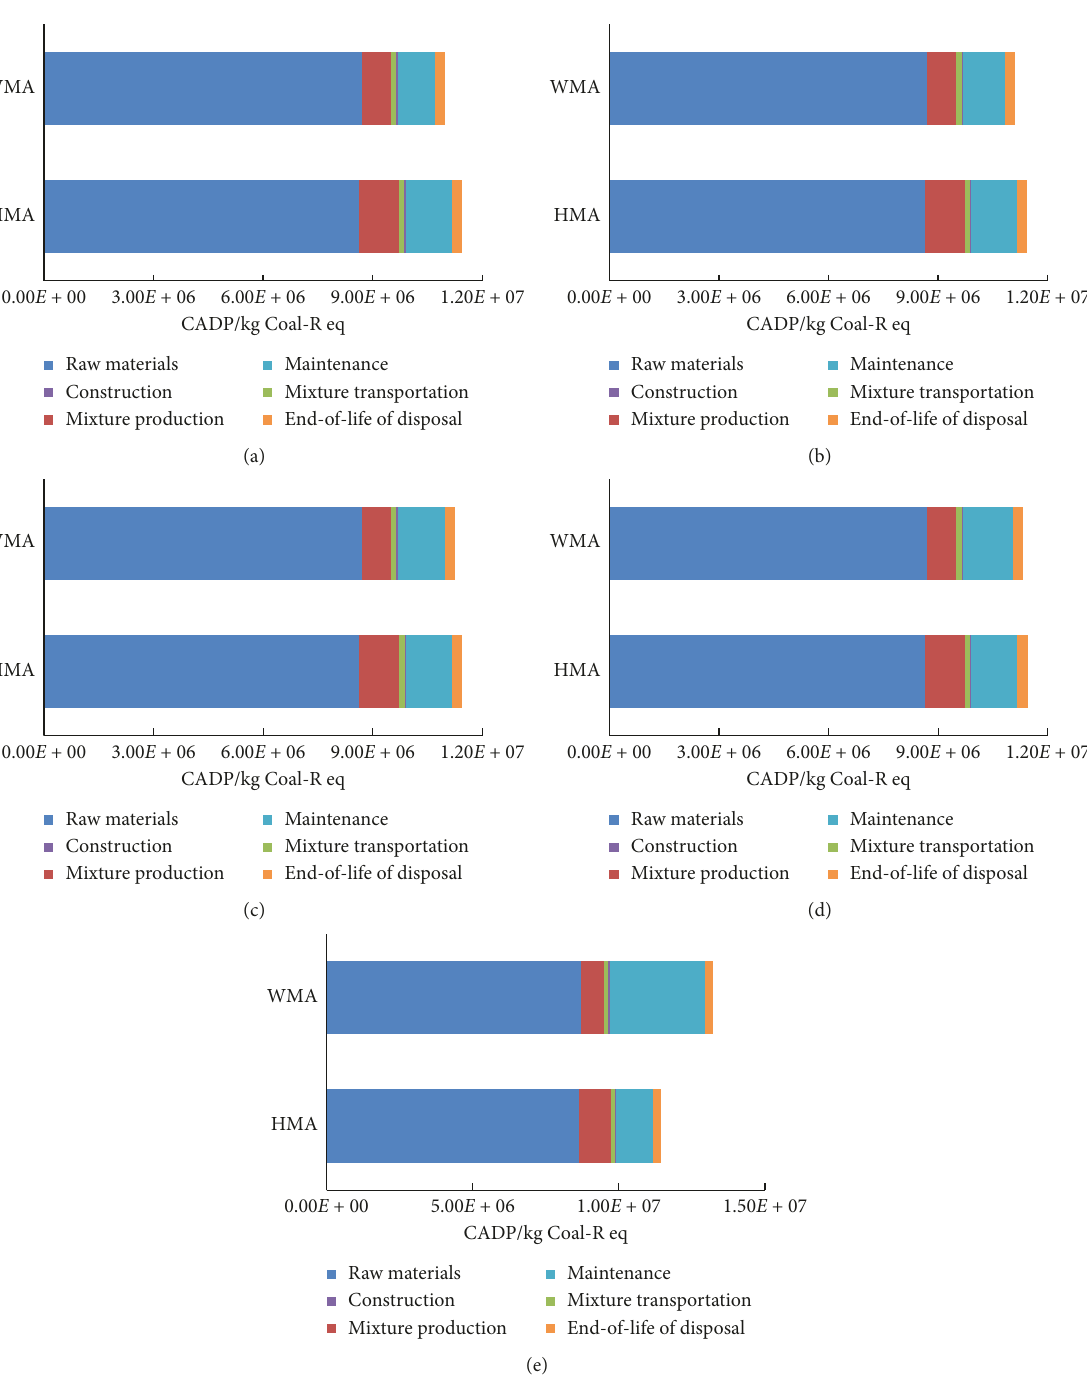
Figure 6: The CADP impacts of HMA and WMA pavements for five cases: (a) case 1; (b) case 2; (c) case 3; (d) case 4; and (e) case